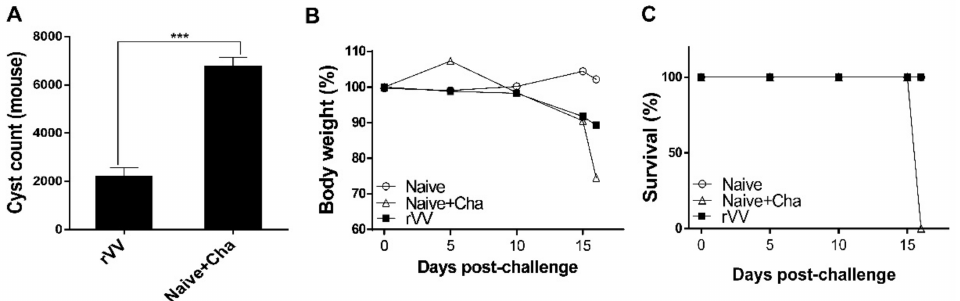
Figure 7. The ROP4-rVV vaccine protects mice against T. gondii ME49. The protective efficacy of the vaccine was evaluated by assessing cyst counts, bodyweight reduction, and survival. Cysts were counted from the right hemispheres of mice ( n = 6 per group) under the microscope ( A ). Mice were monitored daily to check changes in bodyweight ( B ) and survival ( C ). Data are presented as mean ± SD from 3 independent experiments and asterisks indicate statistical differences between groups (*** p <